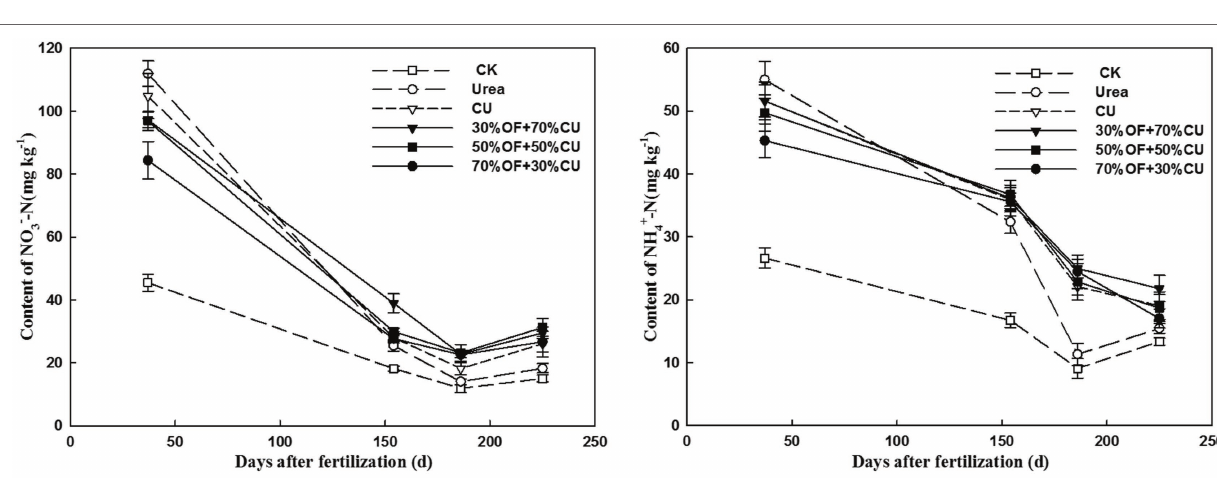
FIGURE 8 | Variations in - NO 3 -N and + NH 4 -N in the 0–20-cm topsoil in